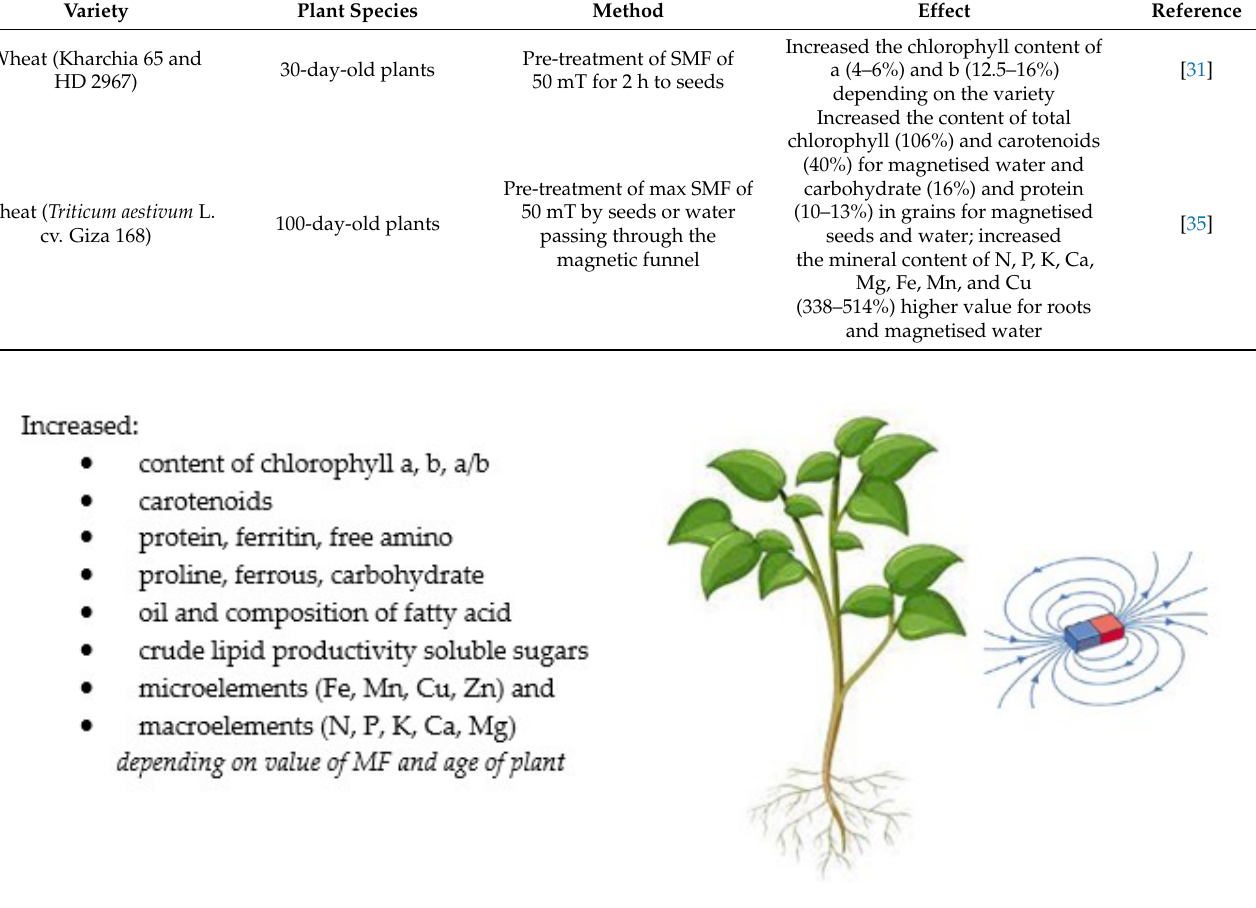
Figure 4. The summary of the effects of MFs on plant components [23,34,91,93,94,100,134,142].